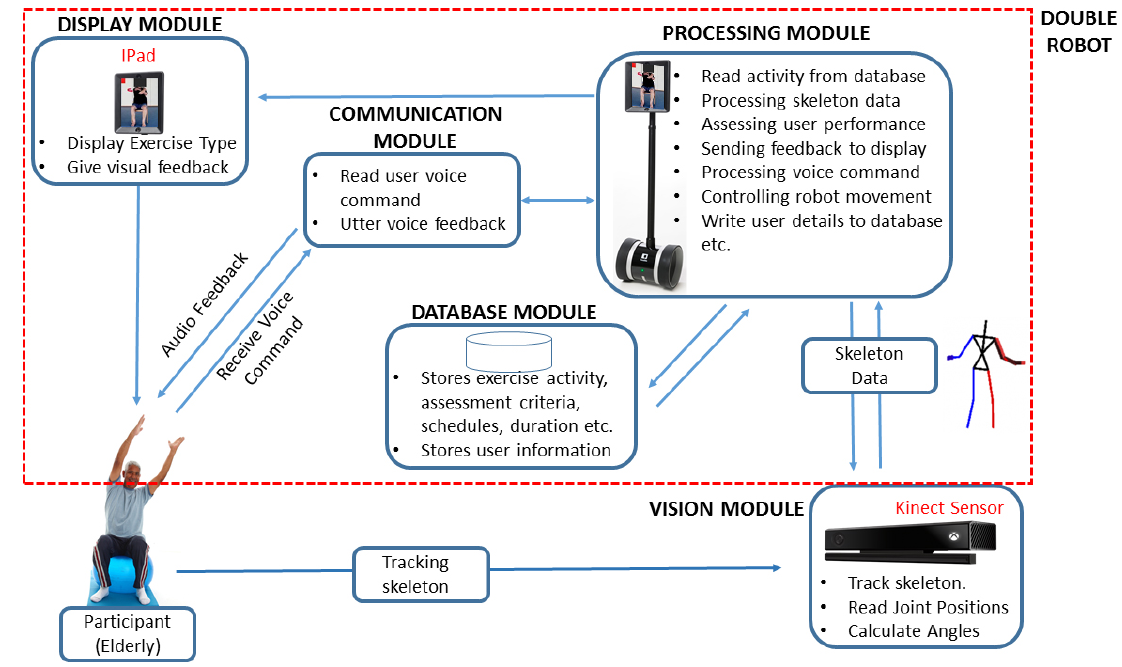
Figure 5. The system diagram of the proposed